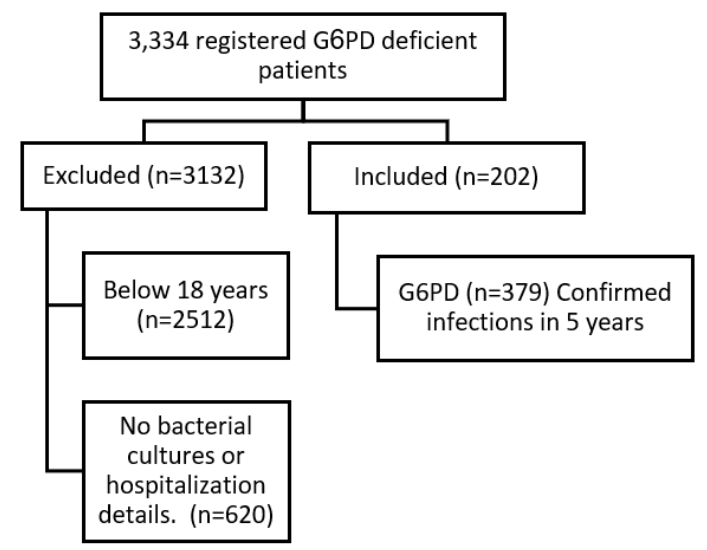
Figure 1. Study population: inclusion and exclusion.